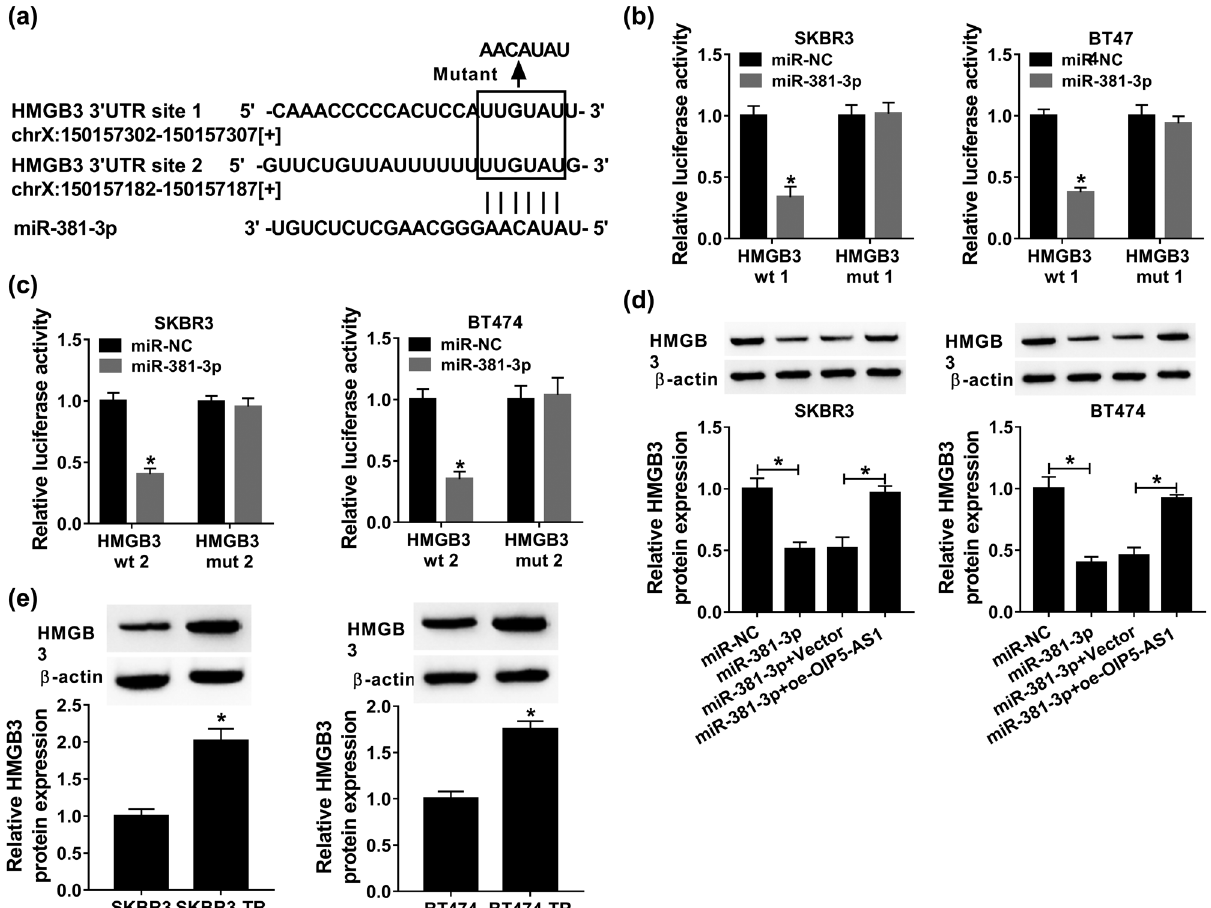
Figure 6: HMGB is a target of miR - 381 - 3p. ( a ) Schematic representation of the predicted binding sites of miR - 381 - 3p on HMGB. ( b and c ) Dual - luciferase reporter assay in SKBR3 and BT474 cells co - transfected with the reporter plasmid and the indicated miRNAs. ( d ) Western blot analysis of HMGB expression in SKBR3 and BT474 cells transfected with miR - NC, miR - 381 - 3p, miR - 381 - 3p + Vector, or miR - 381 - 3p + OIP5 - AS1. ( e ) Western blot analysis of HMGB expression in parental and resistant breast cancer cells. * P <